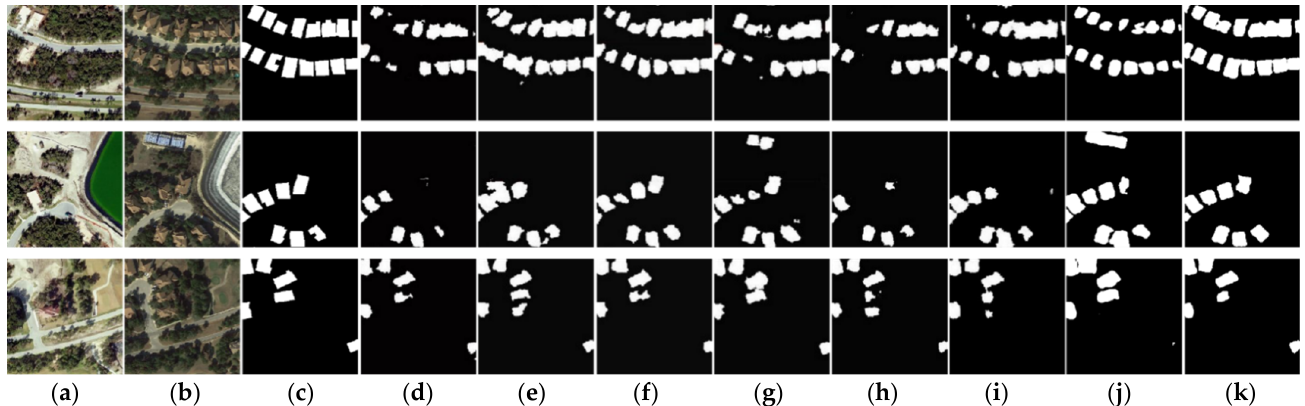
Figure 9. Visualization of eight different methods of LEVIR-CD dataset: ( a ) represents T1 images; ( b ) represents T2 images; ( c ) label; ( d ) are results obtained by CDNet; ( e ) are results obtained by FC-EF; ( f ) are results obtained by FC-Siam-diff; ( g ) are results obtained by FC-Siam-conc; ( h ) are results obtained by FCN-PP; ( i ) are results obtained by CD-UNet++; ( j ) are results obtained by STANet; ( k ) are results obtained by CANet.